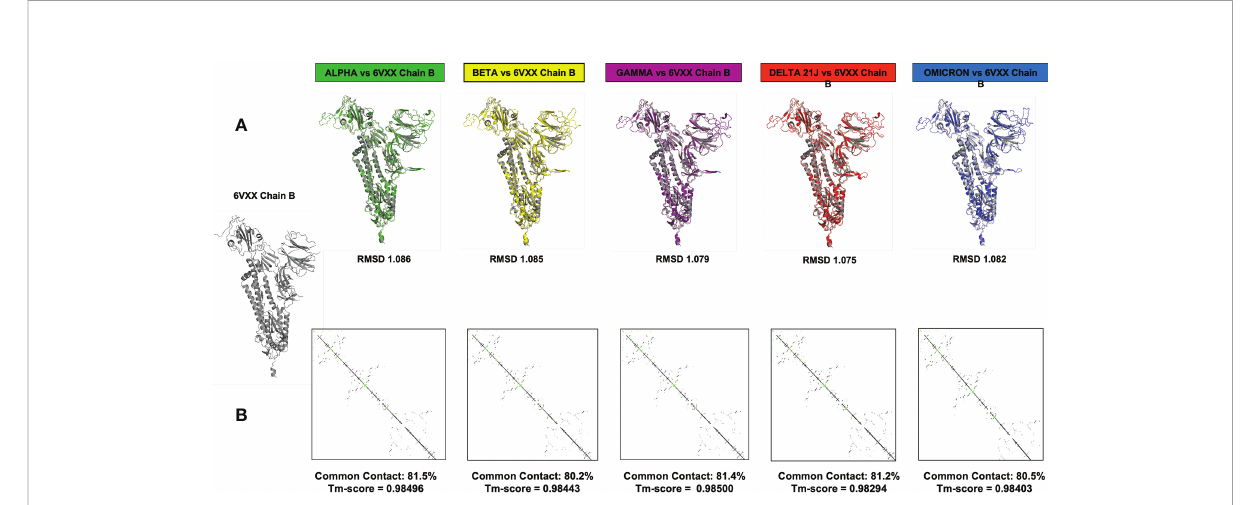
FIGURE 7 This fi gure represents the 3D models generated for the a , b , g , d , and O variants, their structural analysis, and the quality assessment by superimposition with chain B of the crystallized model PBD 6VXX. (A) Superimposition RMSD values. (B) Calculated common contact percentages and Tm